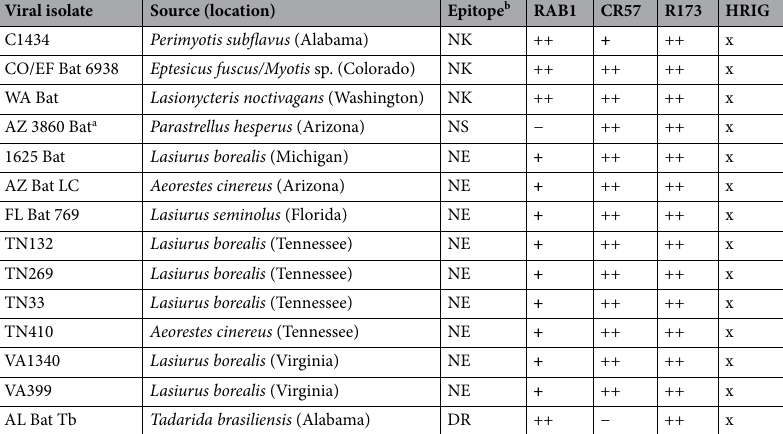
Table 5. RFFIT of RAB1, CR57 and R173 against North America bat isolates. ++ EC 50 < 1 µg /mL. +EC 50 > 1 µg /mL. − Not neutralized by HuMAb at the highest concentration tested. x Neutralized by HRIG. a